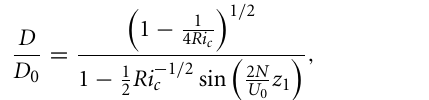
FIGURE 9 | Drag normalized by (30) as a function of Nz 1 / ( π U 0 ). Left: linear flow. Lines: linear theory, symbols: numerical simulations. Solid line and squares: Ri c = 2, dotted line and diamonds: Ri c = 1, dashed line and